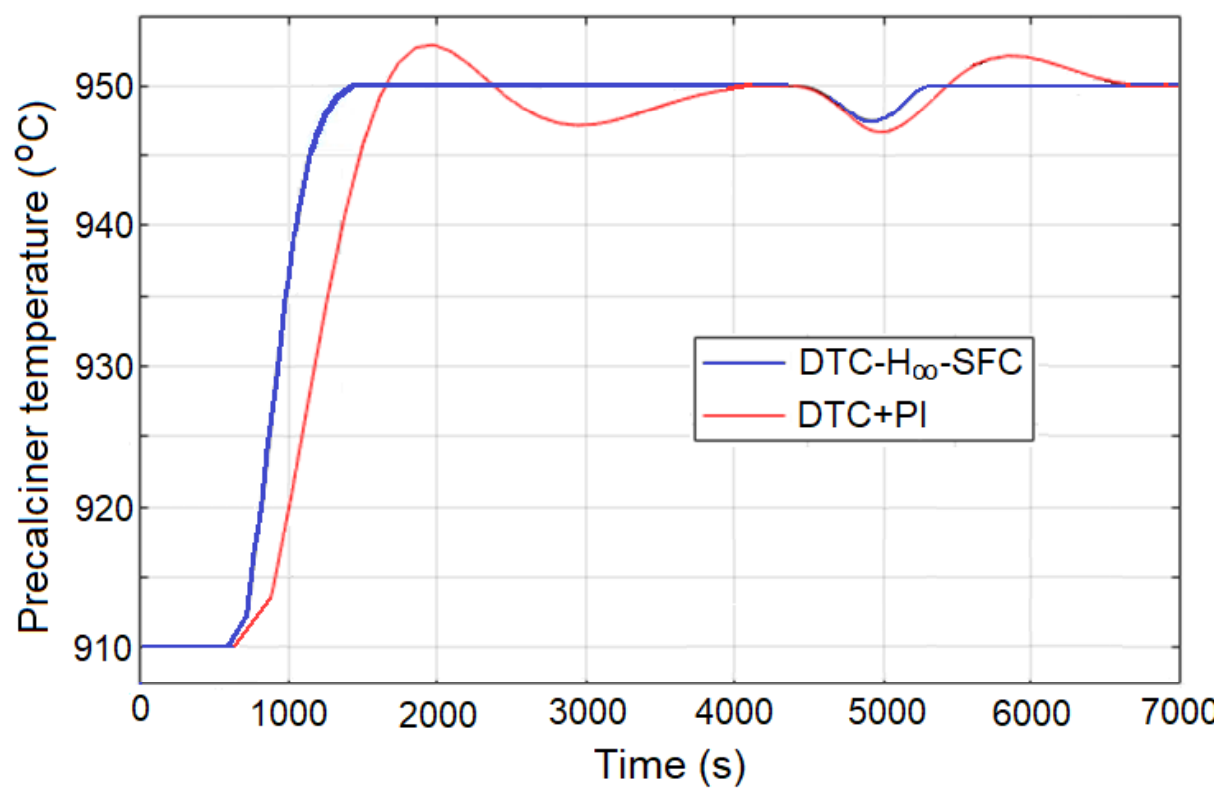
Figure 7. Performance comparative results of the control system with DTC-H ∞ -SFC vs. DTC+PI controllers against variations in the command signal, and external disturbance.